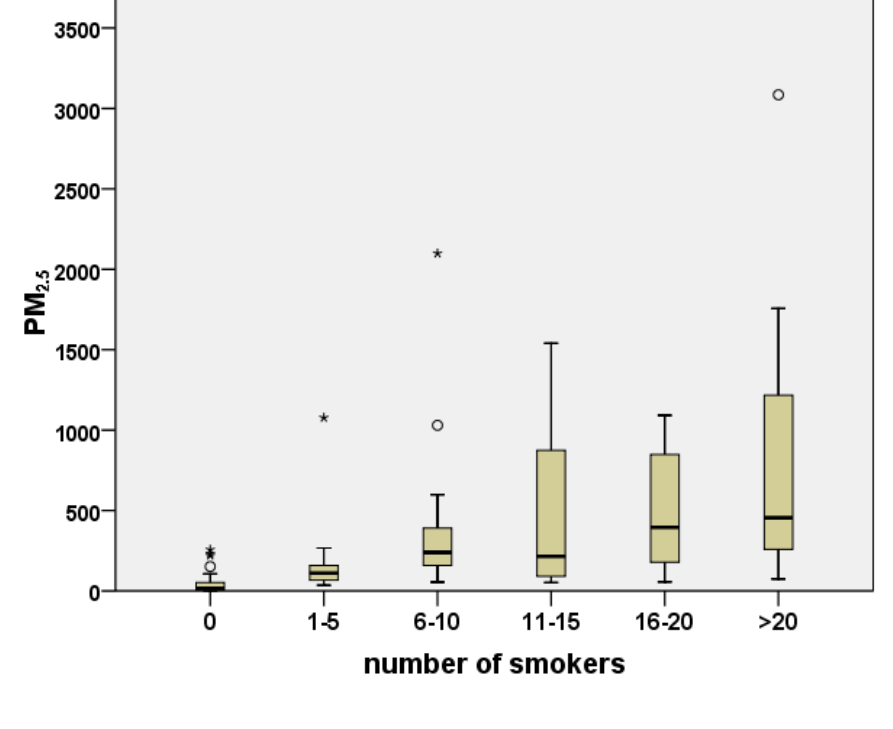
Figure 2. Box plots depicting PM